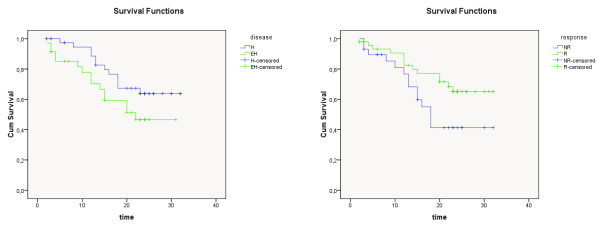
Cumulative survival curves of the R, NR, H and EH subgroups in the whole patient group. Time: months, R: responder, NR: nonresponder, H: hepatic, EH: extrahepatic.